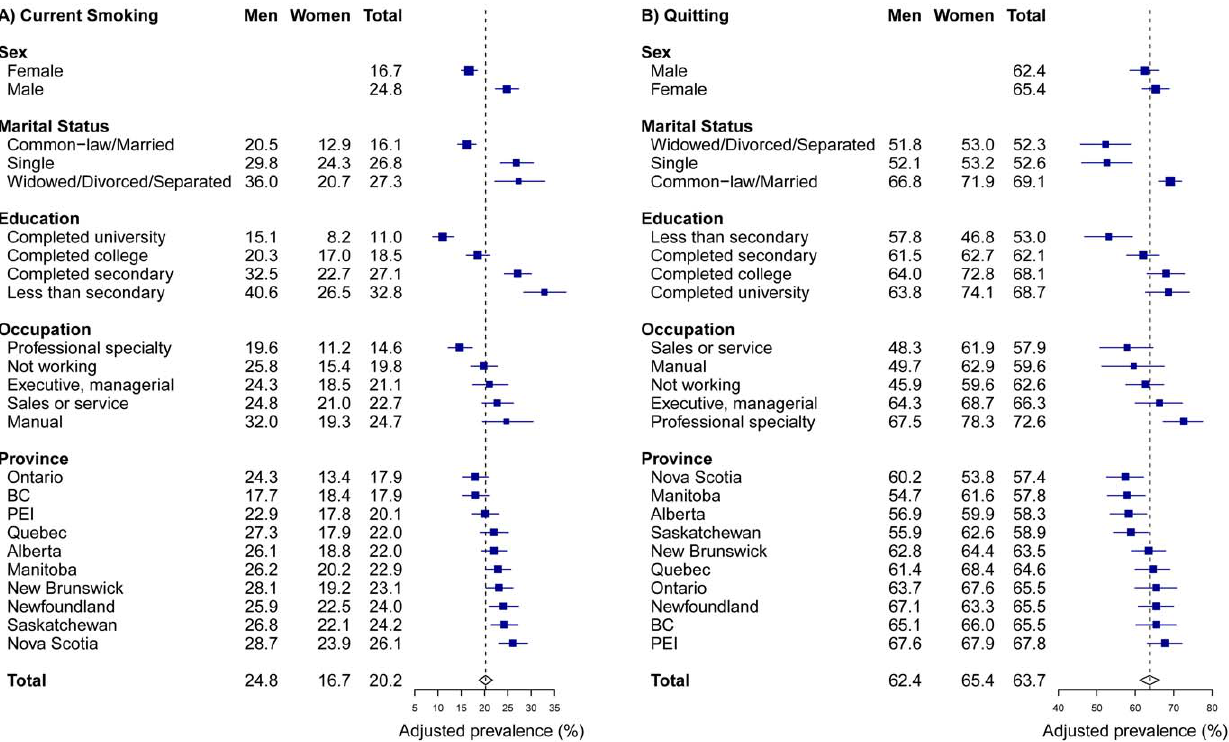
Figure 3. Adjusted prevalence of current smoking and quitting in Canada by demographic and socioeconomic characteristics and province. BC British Columbia; PEI Prince Edward Island.